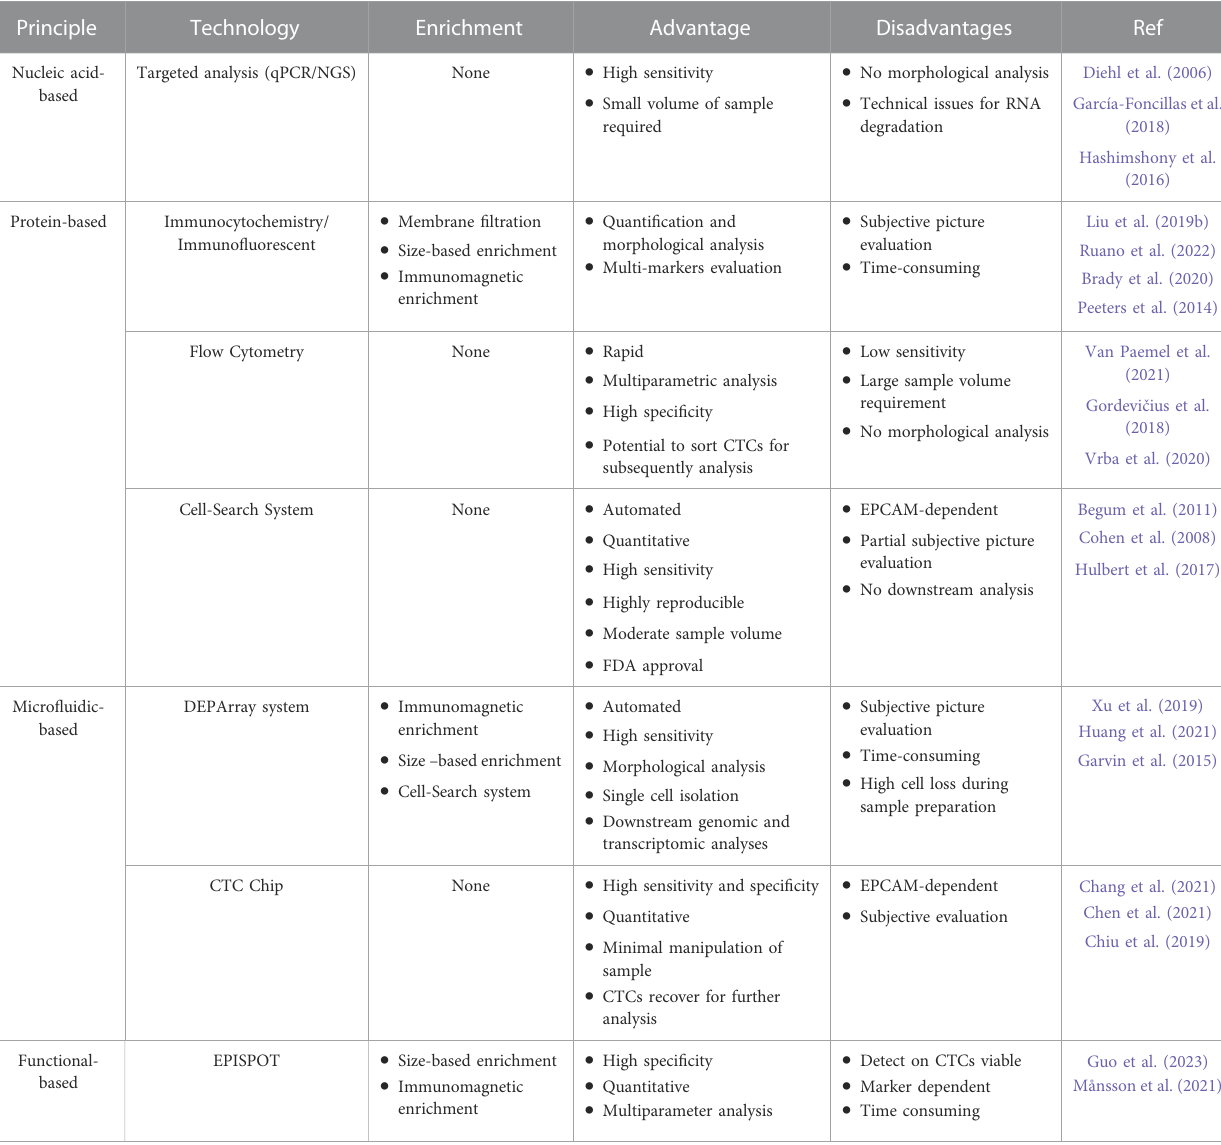
TABLE 1 Main technologies for detection of circulating tumor